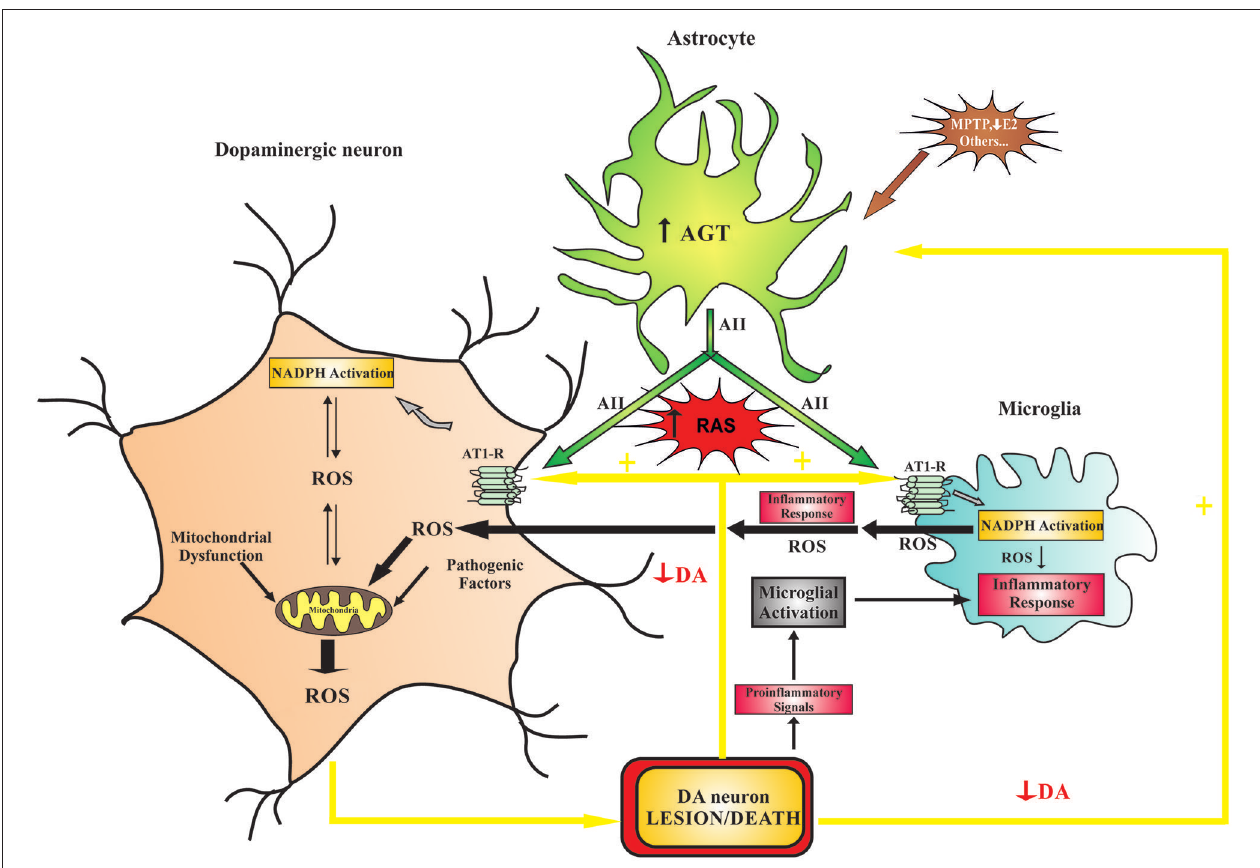
intraneuronal ROS production (in an interaction with mitochondria) and pro-inflammatory signals. In microglial cells, increased RAS activity stimulates the NADPH-oxidase complex, which enhances the inflammatory response, promoting extracellular release of high levels of ROS, activation of ROCK, and the release of cytokines and different neurotoxic factors. ANG, angiotensinogen; AII, angiotensin II; AT1, angiotensin type I receptors; DA, dopamine; E2, estrogen; NADPH, NADPH-oxidase complex; RAS, renin-angiotensin system; ROCK, Rho-associated kinase; ROS, reactive oxygen